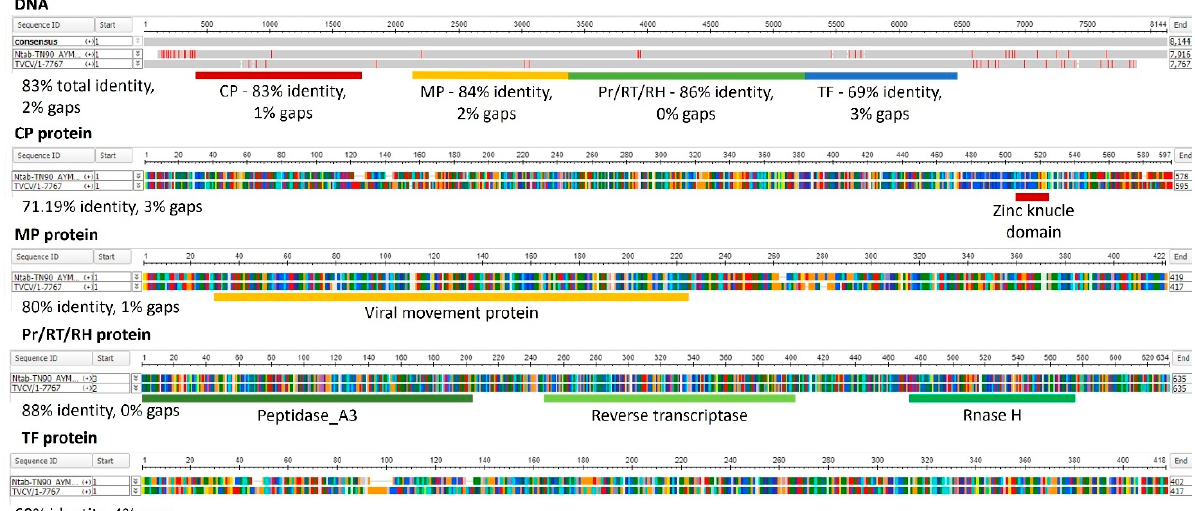
Figure 2. Alignments of tobacco TVCV-related sequence Ntab-TN90_AYMY-SS16611 and TVCV genomic sequences and the predicted proteins. Alignments were obtained by Clustal Omega (https://www.ebi.ac.uk/Tools/msa/clustalo; accessed on 20 April 2021) and visualized by Multiple Sequence Alignment Viewer 1.20.0 (https://www.ncbi.nlm.nih.gov/projects/ msaviewer; accessed on 20 April 2021). The percentage of sequence similarity and gaps are reported for each alignment. The four ORFs in the TVCV genome are highlighted for the DNA alignment: red—CP (coat protein) encoding ORF1, yellow—MP (movement protein) encoding ORF2, green—Pr (peptidase)/RT (reverse transcriptase)/RH (Rnase H) encoding ORF3, blue—TF (transactivator factor) encoding ORF4. Red bars in the DNA alignment indicate sequence differences. The protein domain detected by Pfam (http://pfam.xfam.org/; accessed on 20 April 2021) are indicated in the protein alignments. The function of RasMol amino acid colors has been